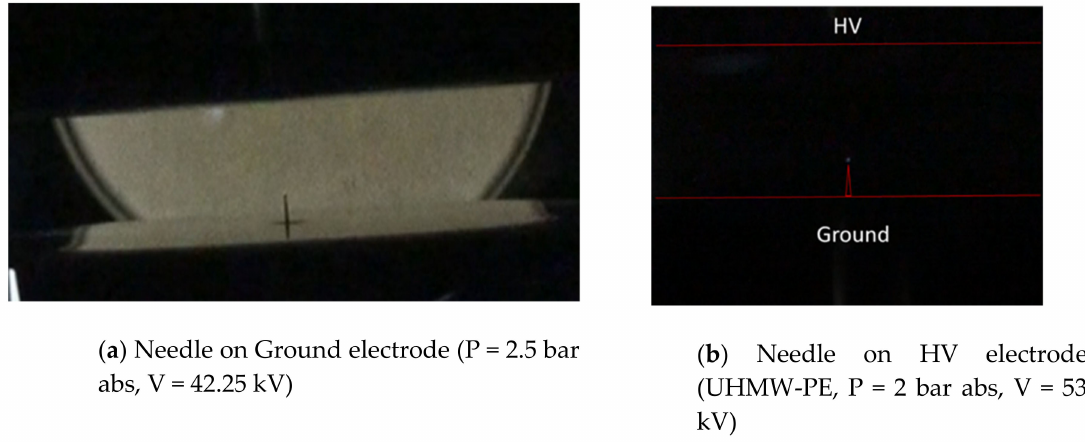
Figure 20. Positive glow corona onset: for 4%Novec TM 4710 / 96% CO 2 for an applied